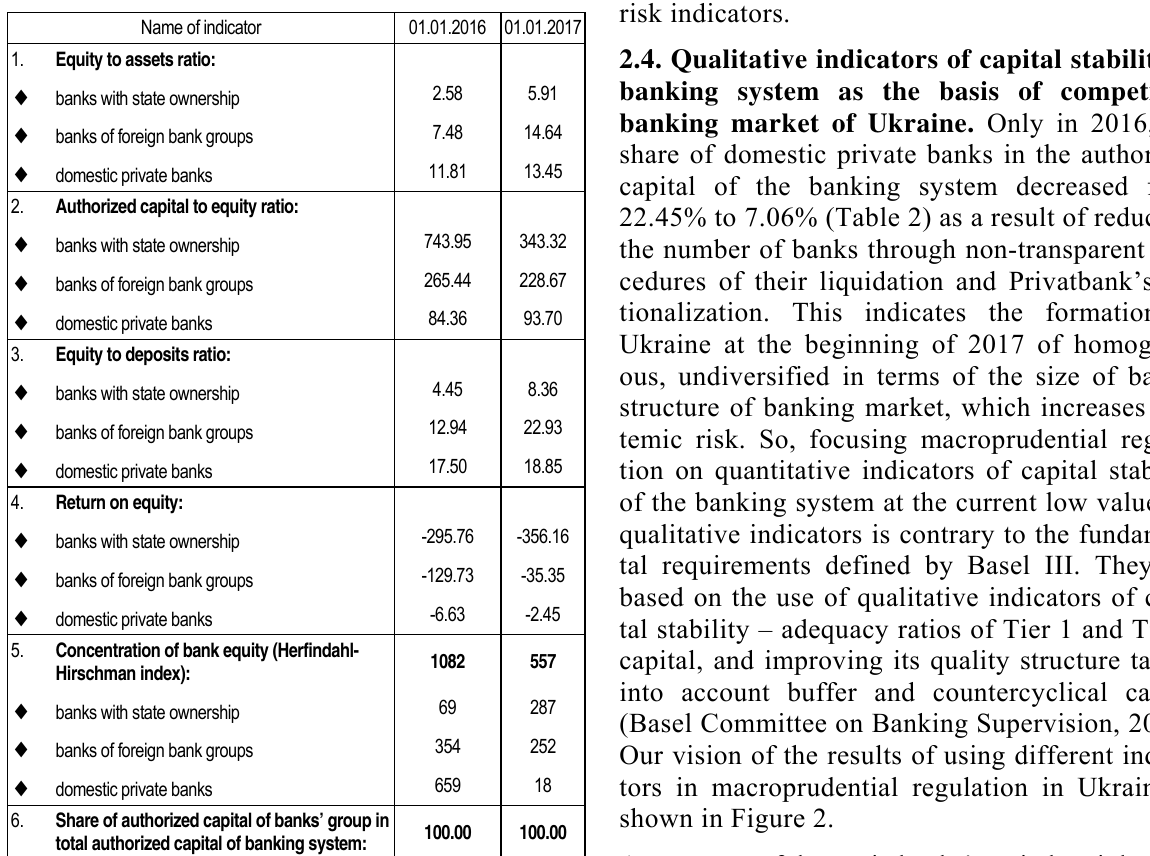
Table 2. Key capital stability indicators of the groups of solvent banks of Ukraine in 2016 * ,